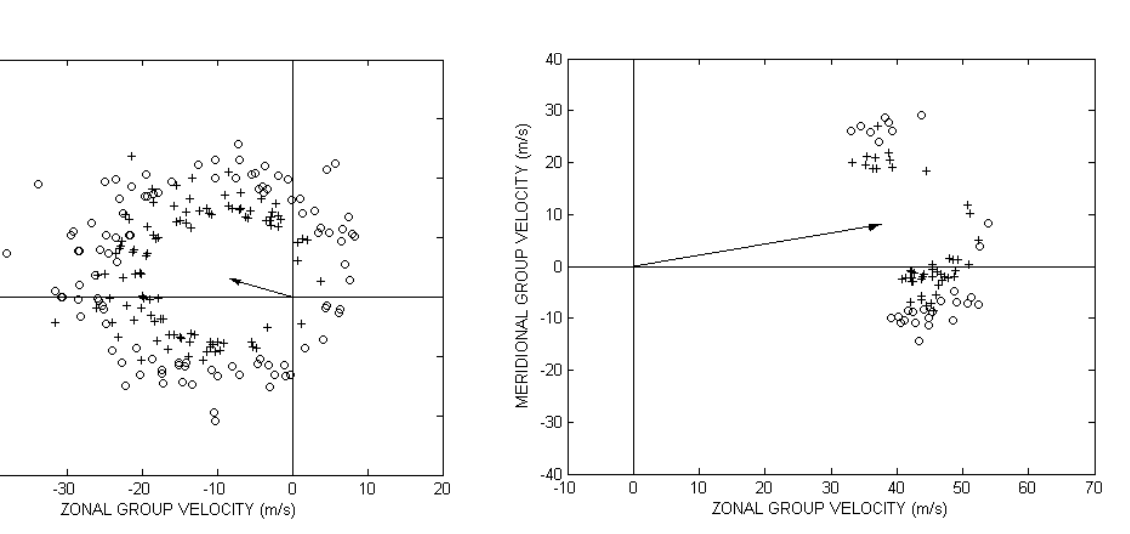
Fig.6 Scattering plot of the virtual horizontal group velocities of the upward gravity Fig. 6. Scattering plot of the virtual horizontal group velocities of wave packets of the winter data. Wave packets obtained by windows T3aZ4, the upward gravity wave packets of the winter data. Wave pack- T3bZ4 and T3cZ4 were denoted by ‘cross’ ; wave packets obtained by windows ets obtained by windows T3aZ4, T3bZ4 and T3cZ4 were denoted T3aZ5, T3bZ5 and T3cZ5 were denoted by ‘open circle’ . These gravity wave by cross; wave packets obtained by windows T3aZ5, T3bZ5 and T3cZ5 were denoted by open circle. These gravity wave packets packets were selected from the gravity wave packets in Fig.4. were selected from the gravity wave packets in Fig. 4.